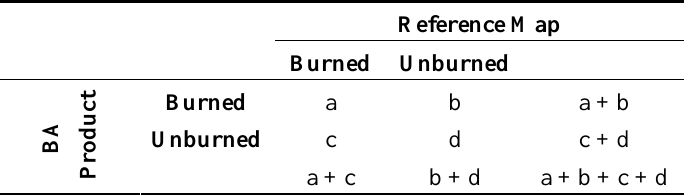
Table 2. Contingency table for the dichotomous case of pixels classified as burned vs. unburned over a given study